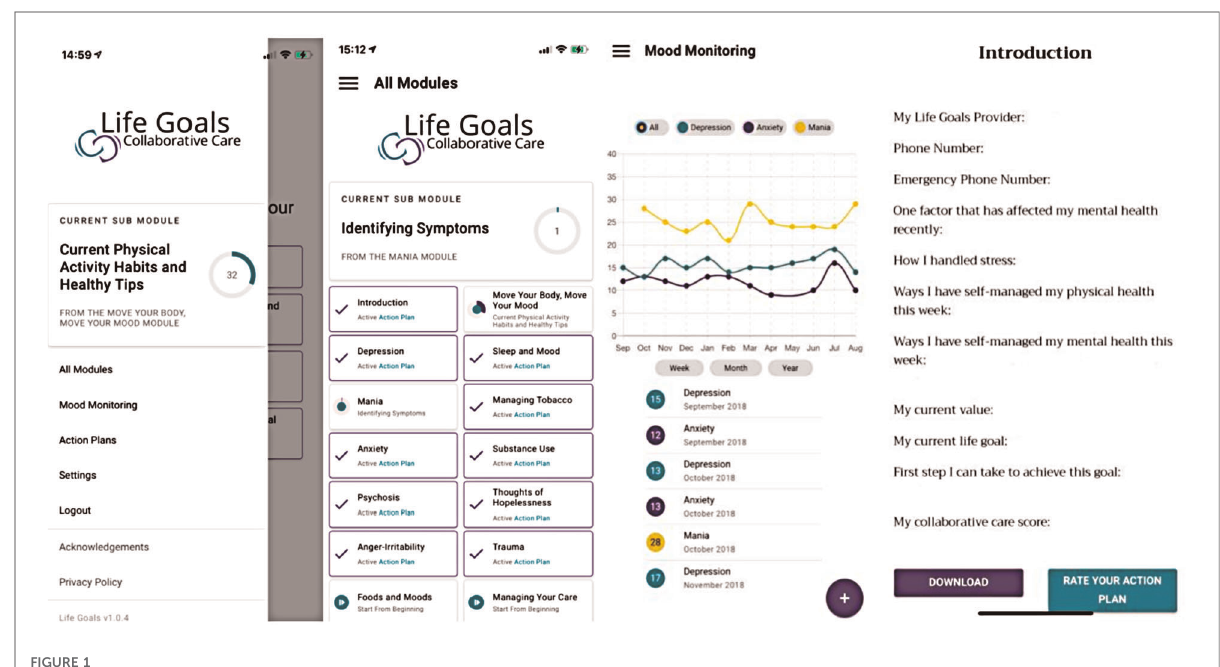
FIGURE 1 Life Goals app interface.